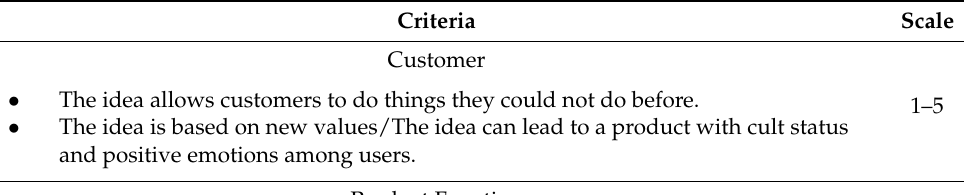
Criteria Customer